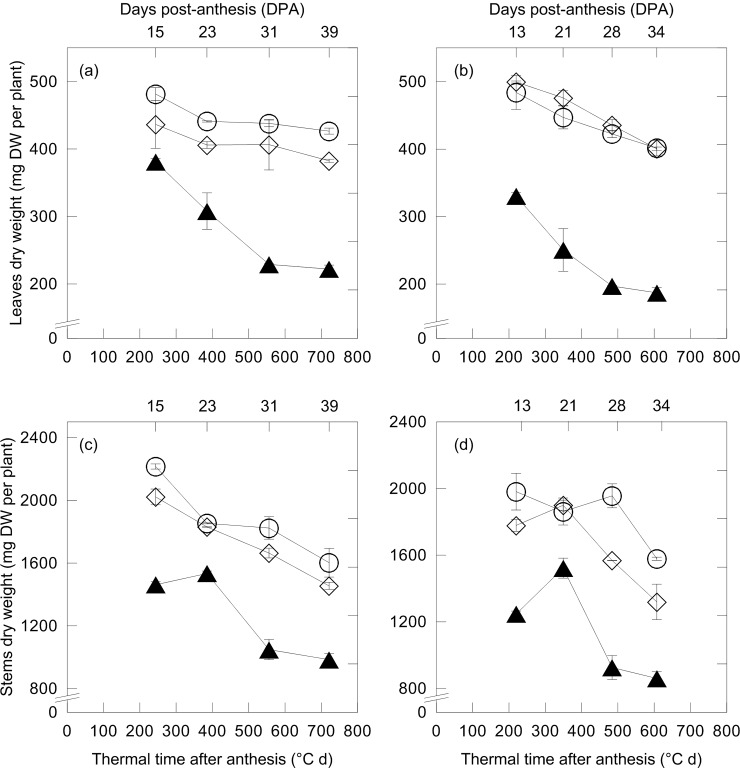
Changes of leaves dry weight (mg DW per plant) and stems dry weight (mg DW per plant) against thermal time after anthesis (cumulative average daily air temperature exceeding 0°C, °C d) and days post-anthesis (DPA) (above axis) of durum wheat in 2011 (a and c, respectively) and 2012 (b and d, respectively). Wheat plants were exposed to control conditions (unfertilized CONTROL, black triangle) and to two N fertilization treatments with urea (UREA, white rhombus) and calcium nitrate (NITRATE, white circle) at the rate of 150 kg N ha-1 (mean value ± standard errors, n = 3 independent replicates; split-plot ANOVA over thermal time after anthesis; effects: (a) treatment, P < 0.01; time, P < 0.01; treatment x time, P = 0.08; (b) treatment, P < 0.01; time, P < 0.01; treatment x time, P = 0.33; (c) treatment, P < 0.05; time, P < 0.01; treatment x time, P < 0.01; (d) treatment, P < 0.05; time, P < 0.01; treatment x time, P < 0.05).